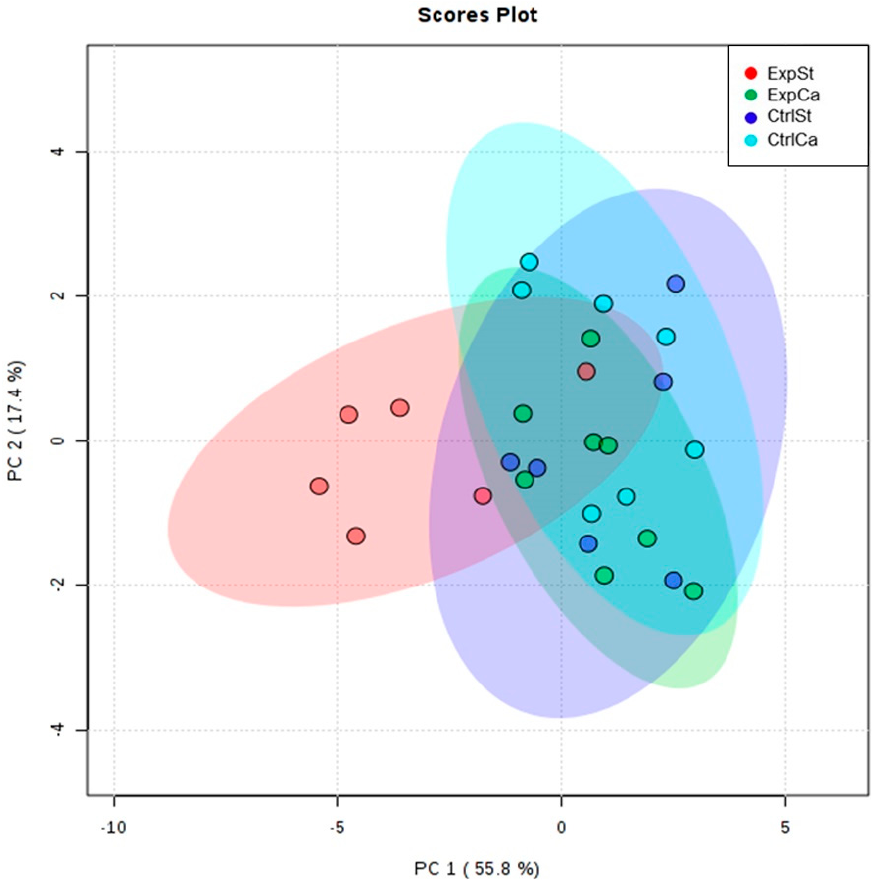
Figure 3. The Principal Component Analysis performed on four groups—rats on the standard diet with LNCaP (red dots—ExpSt); rats on the standard diet without LNCaP (blue dots—CtrlSt); rats with Ca supplementation with LNCaP (green dots—ExpCa); rats with Ca supplementation with- out LNCaP (light blue dots—CtrlCa).